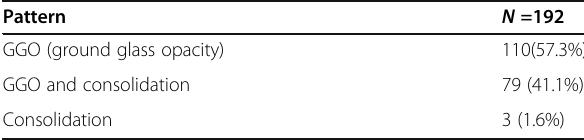
Table 2 Pattern of pulmonary affection in our